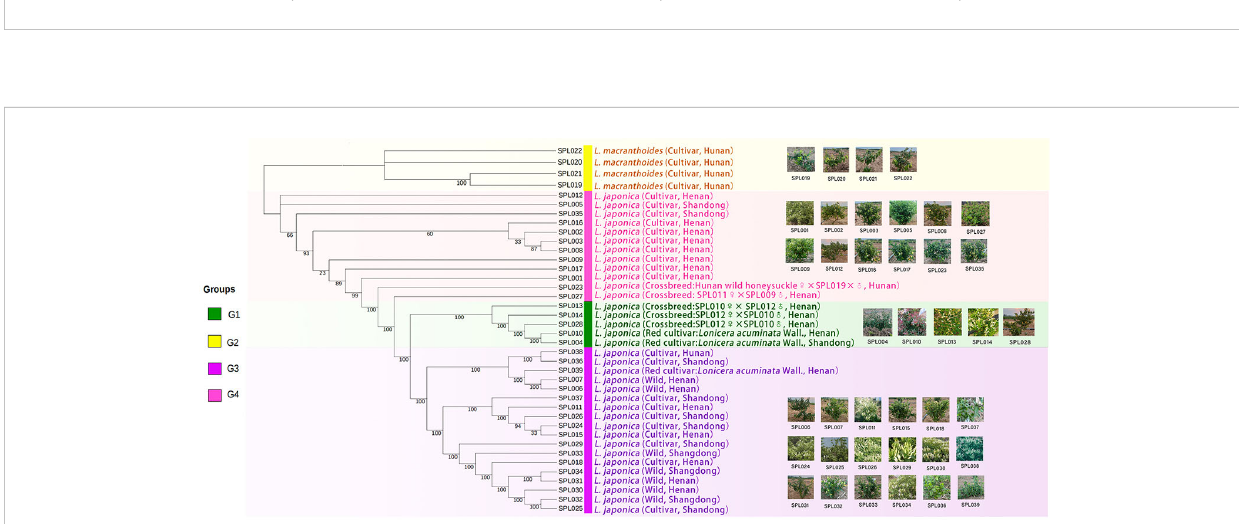
FIGURE 4 Phylogenetic tree of 39 Lonicera varieties. G1 is a L. japonica variety with red and light red fl ower buds; outgroup G2 is L. macranthoides ; G3 is mainly wild L. japonica from Shandong and Henan; and G4 is a mature and highly recognized L. japonica in the current market. The text annotation in the fi gure is: species name (species type,